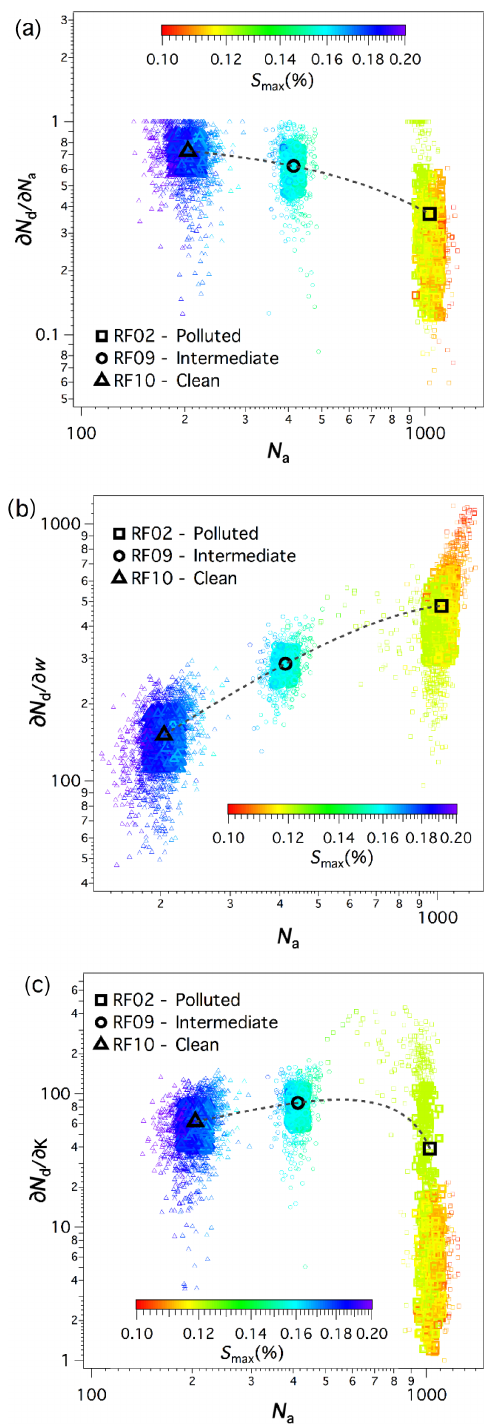
Figure 4. The sensitivity of the droplet number to (a) aerosol num- ber ( ∂N d /∂N a ), (b) characteristic velocity ( ∂N d /∂w ∗ ), and (c) hy- groscopicity parameter ( ∂N d /∂κ ) as functions of N a (cm − 3 ). The data are clustered using the polluted, intermediate, and clean group- ings of Table